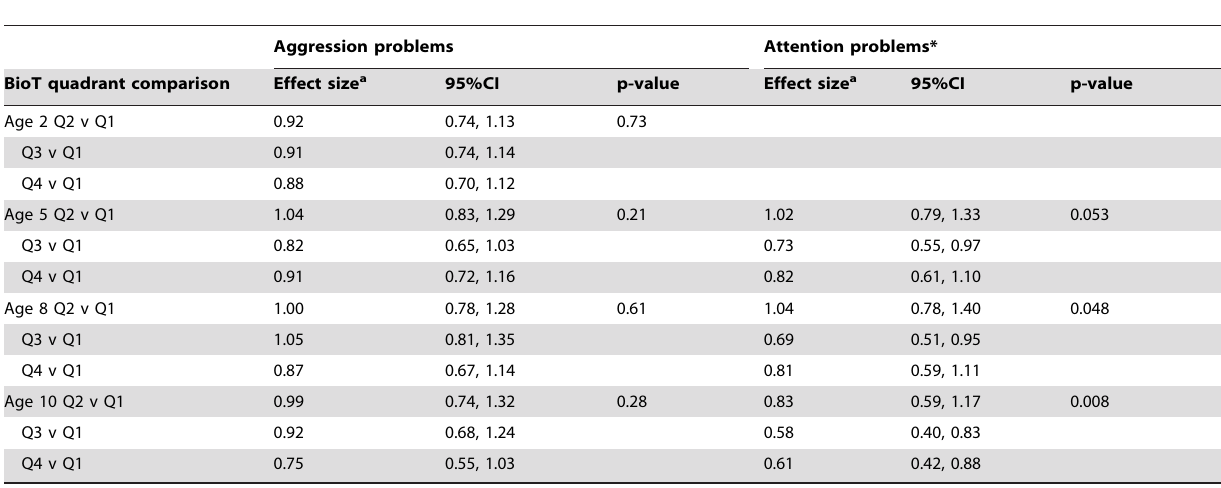
Table 4. Modeled effect of prenatal bioavailable testosterone (BioT) levels on raw syndrome scores-